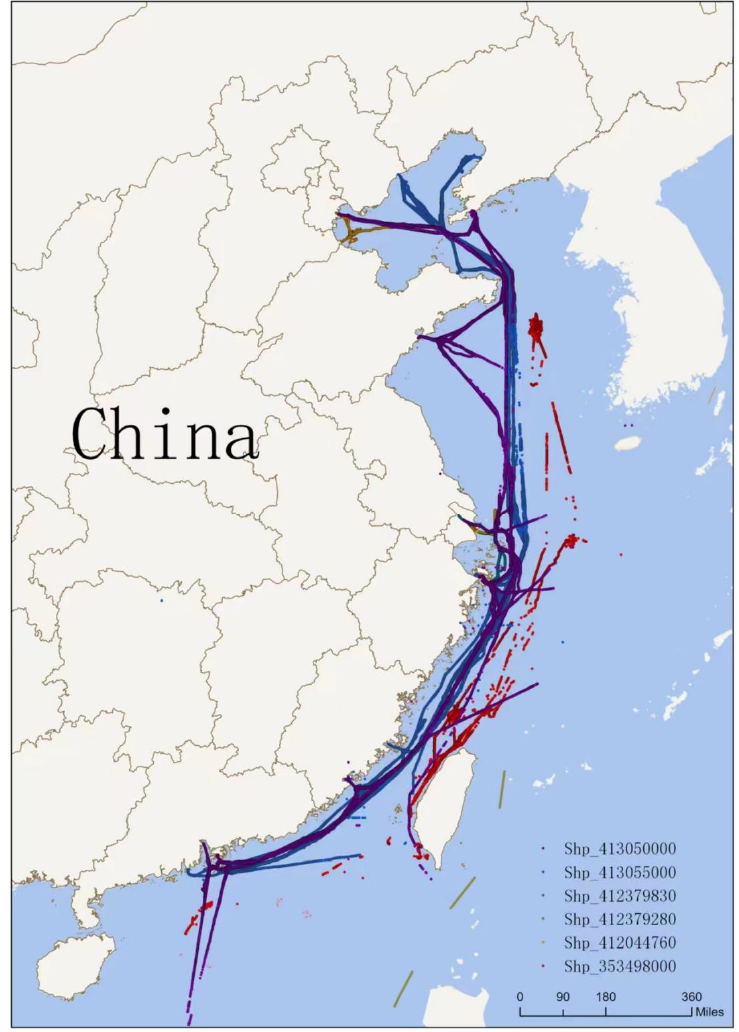
Figure 2. Tracks of the sampled ships in 2019.